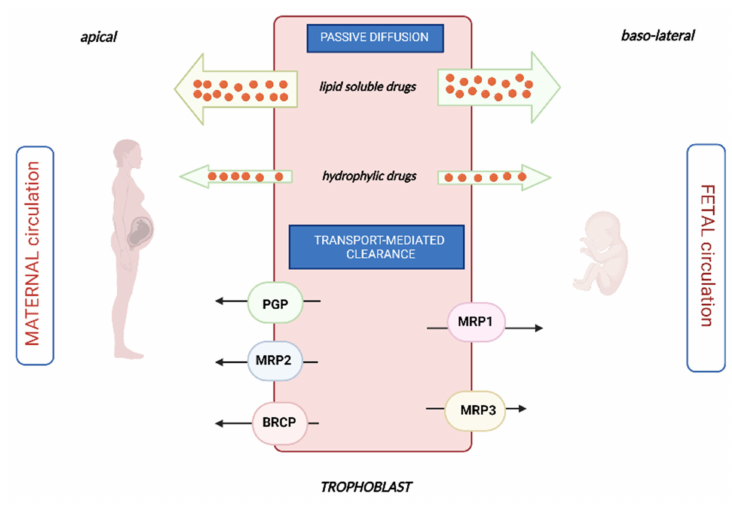
Figure 1. Mechanisms of transplacental passage of